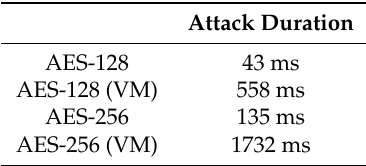
Table 5. Mean times required for gathering the data of Figure